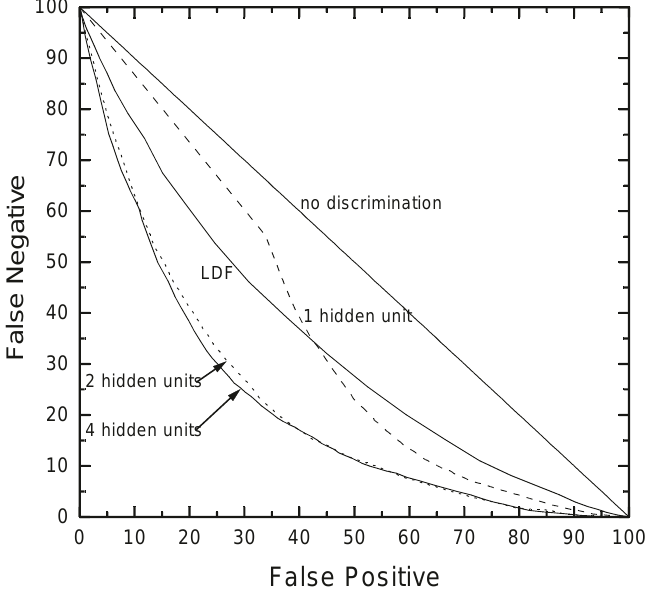
Fig. 2. The cell-by-cell ROC curves for the LDF and networks giving the best test set classification rate are shown. The ROC curves for the best networks using three, five, six and seven hidden units nearly coincide with those of the networks with two and four hidden units and are not